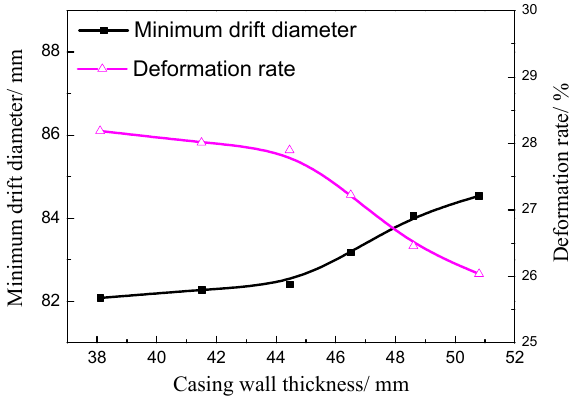
Figure 13. Effect of cement sheath wall thickness on casing diameter.